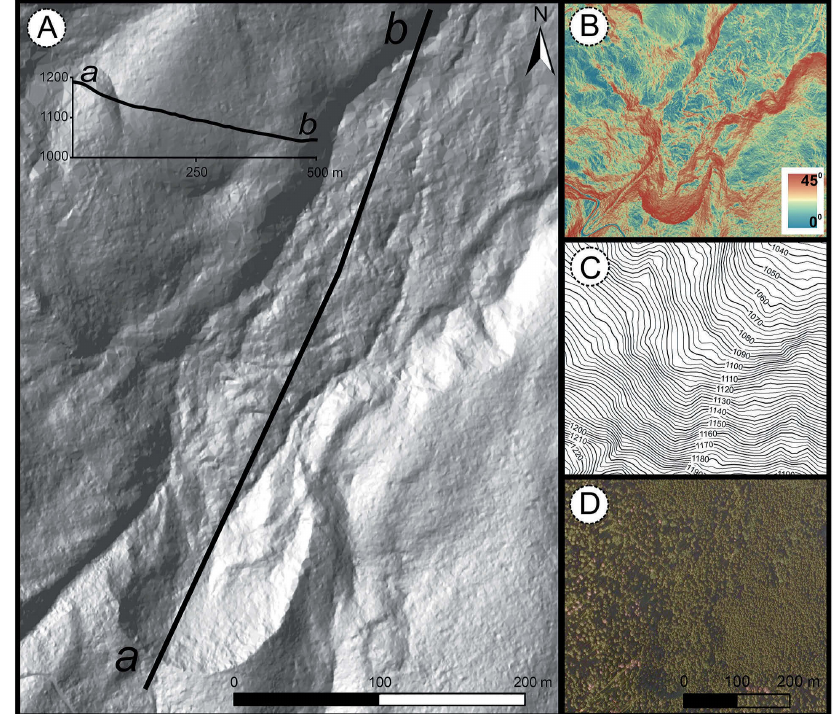
Fig. 8. Test area No 7. A – LiDAR image (a–b – topographic profile and its location), B – the map of slope reductions generat- ed from LiDAR (range of slope reductions is given), C – contour-line map, D – orthophotomap. Maps B–D at the same scale, Map A at larger scale